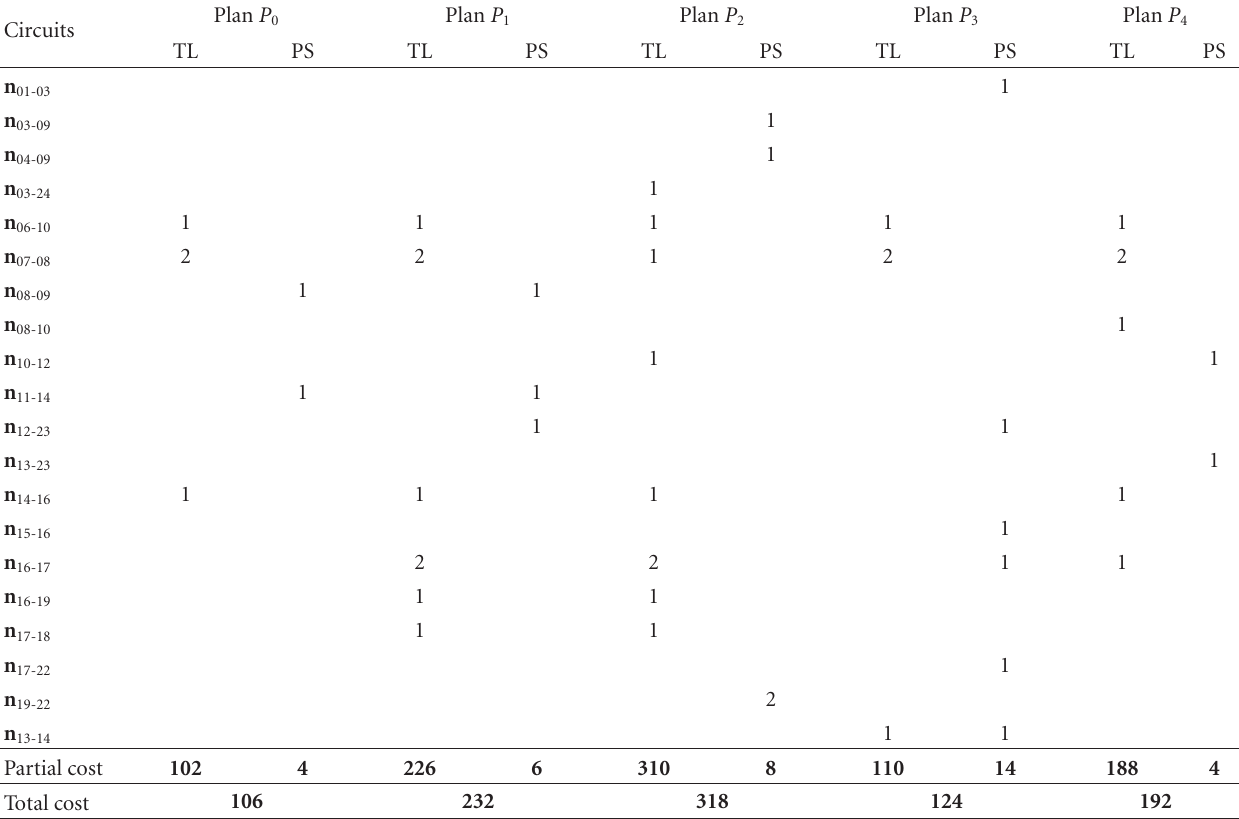
Table 3: Five transmission expansion plans considering low-cost phase-shifter